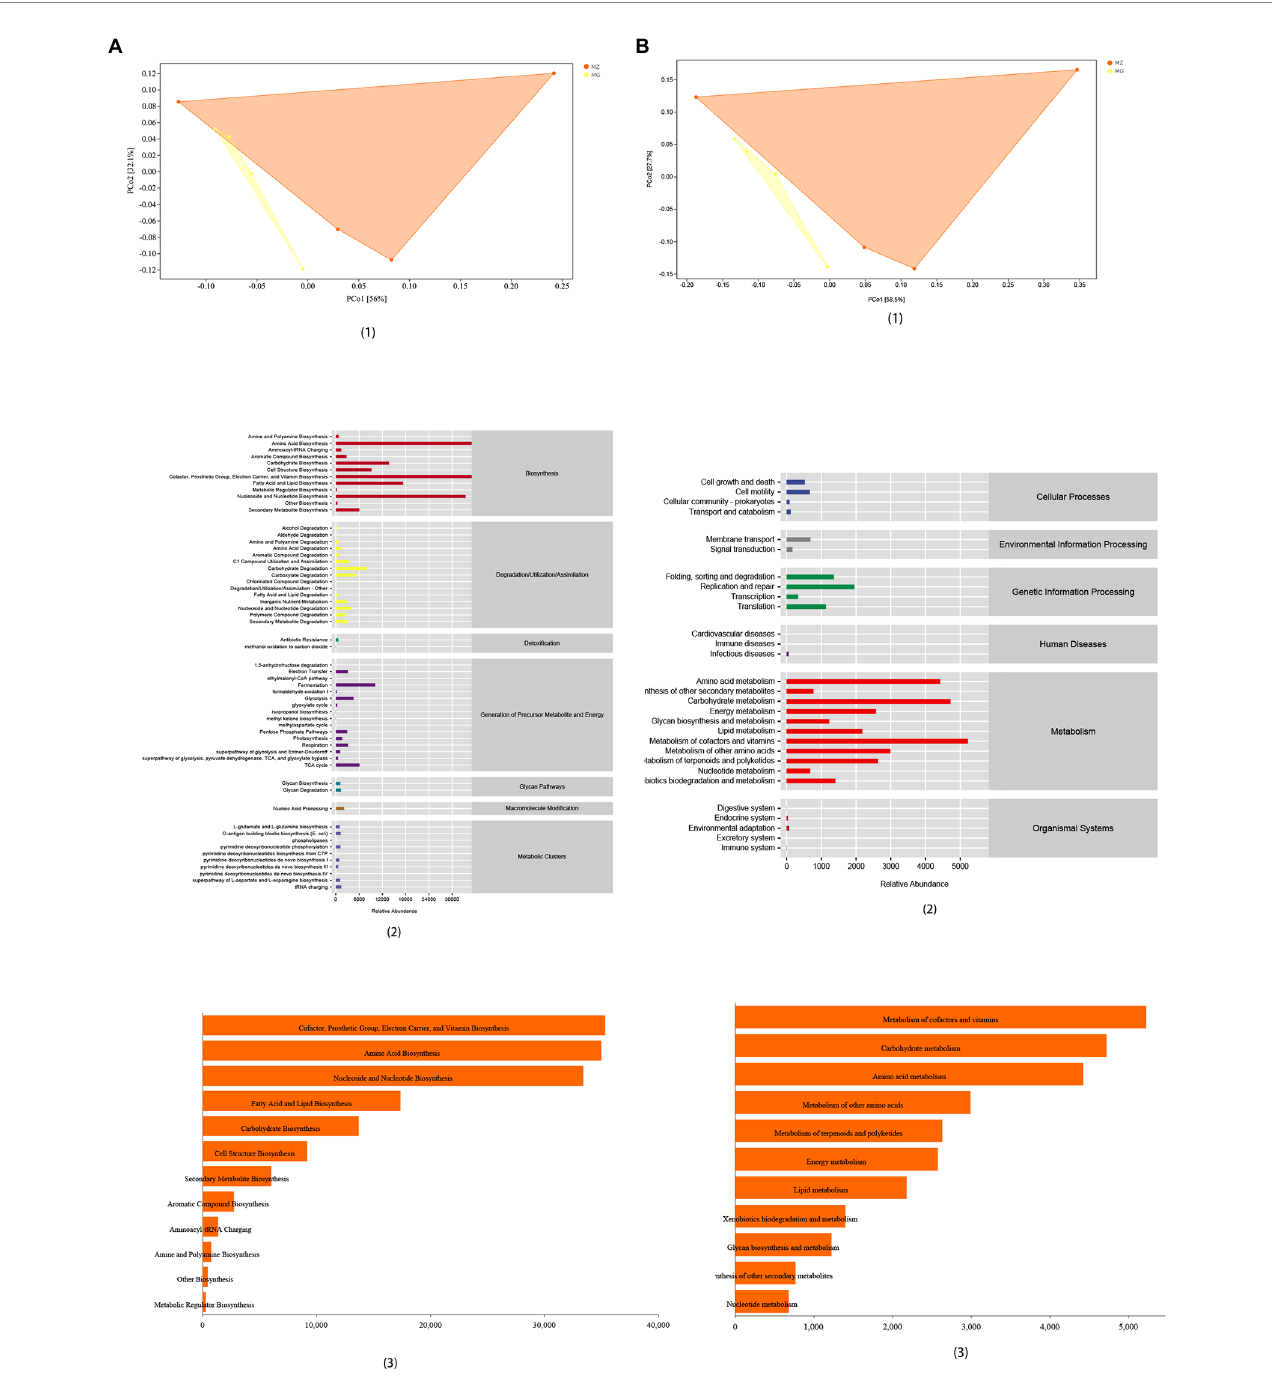
FIGURE 6 Functional analysis of intestinal mucosal microbiota. (A) PCoA map, predicted abundance and histogram of metabolic function with the greatest impact based on MetaCyc functional databases. (B) PCoA map, predicted abundance and histogram of metabolic function with the greatest impact based on KEGG functional